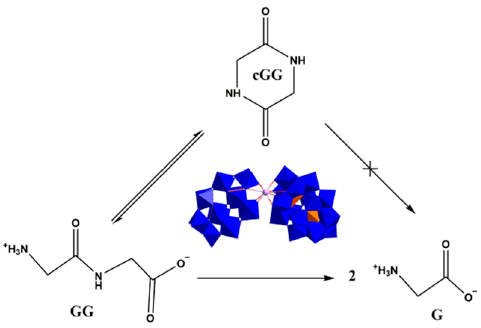
Scheme 2. Schematic diagram of hydrolysis of GG in the Presence of